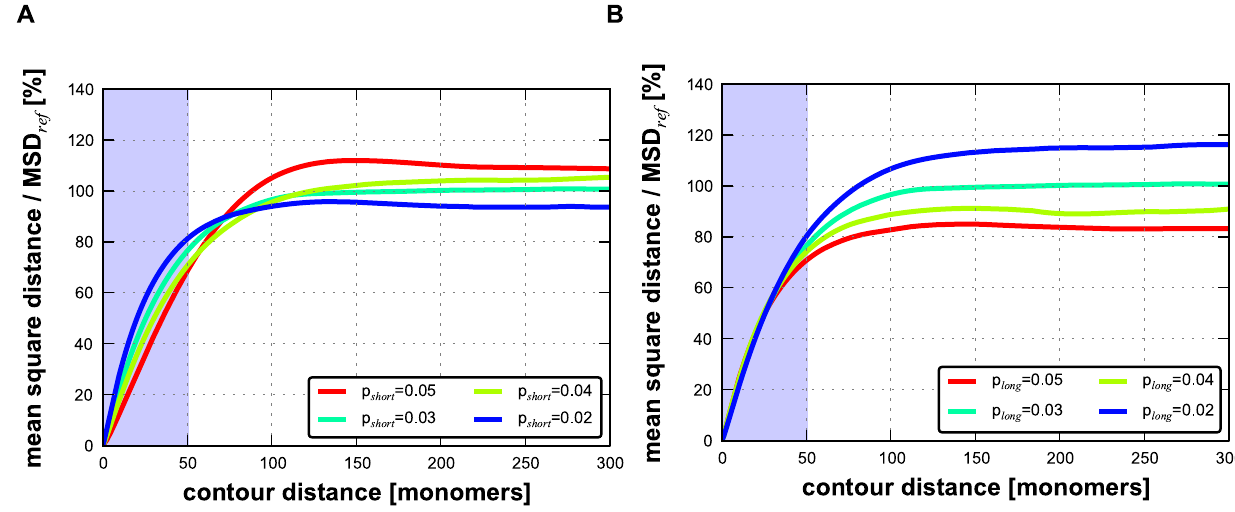
Figure 4. Effect of short-range and long-range looping probabilities on the relationships between the MSD and the contour distance in the adapted DL polymer model. ( A ) Varying the short-range looping probability at constant long-range looping probability (p long 0.03). ( B ) Varying long-range looping probability at constant short-range looping (p short 0.03). The MSD plateau levels is a measure of overall polymer compaction. The simulations show that decreasing the long-range looping probability results in expansion of the polymer, while lowering short- range looping probability leads to compaction. To facilitate comparison between the two effects, the MSD was normalized by the plateau level of the MSD for p long =0.03 and p short =0.03 (MSD ref ) because this parameter combination is present in both figures.